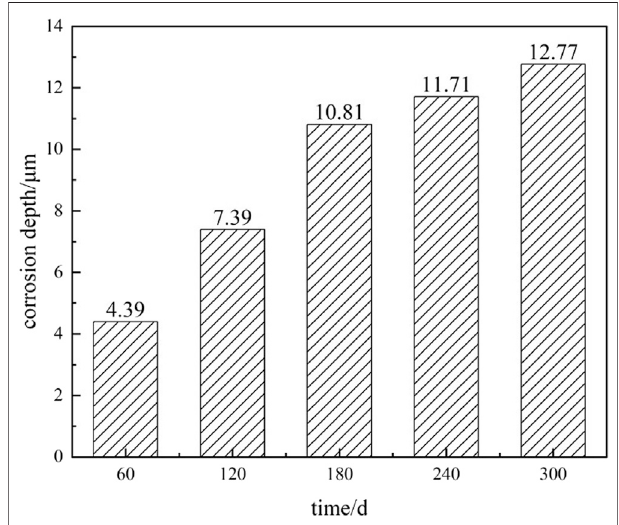
FIGURE 15 | Relationship between the corrosion depth and time after CA